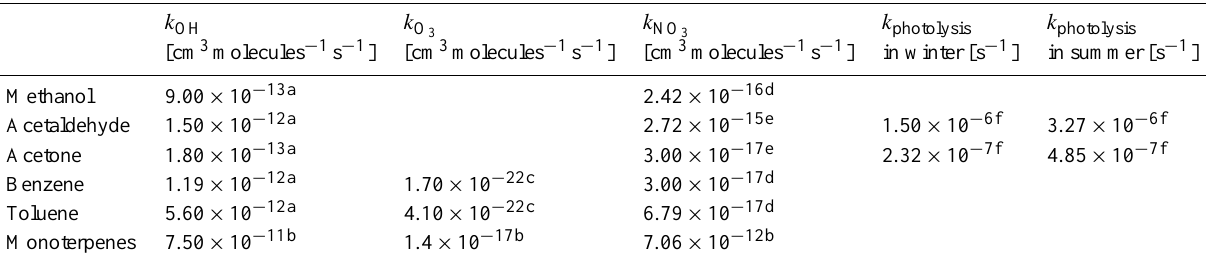
Table 3. Reaction rate coefficients ( k OH , k O